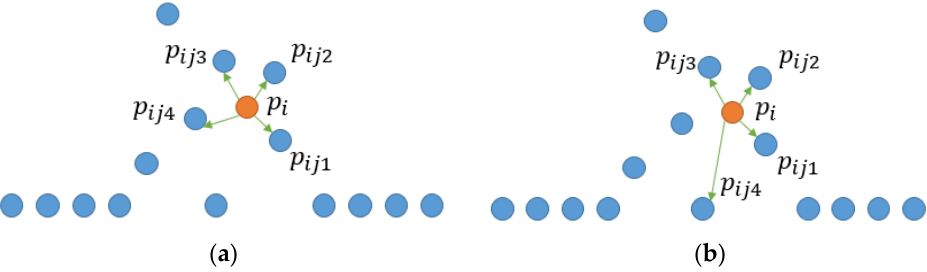
Figure 3. Difference between ( a ) classic k-nearest neighbors (KNN) and ( b ) Tin-KNN graphs. Figure 3. Di ff erence between ( a ) classic k-nearest neighbors (KNN) and ( b ) Tin-KNN